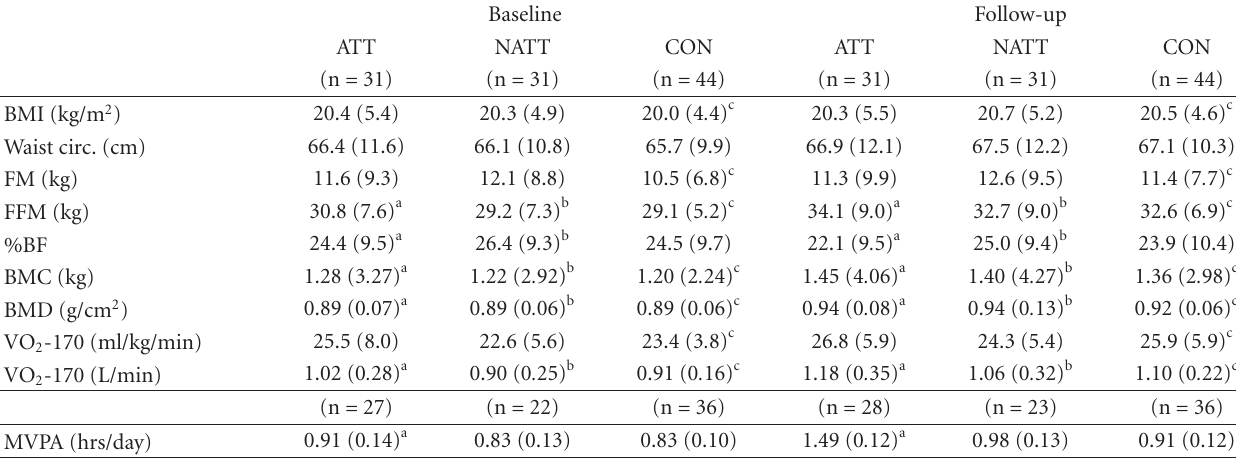
Table 2: Body Composition, CV Fitness and PA measures by Group (Means ±